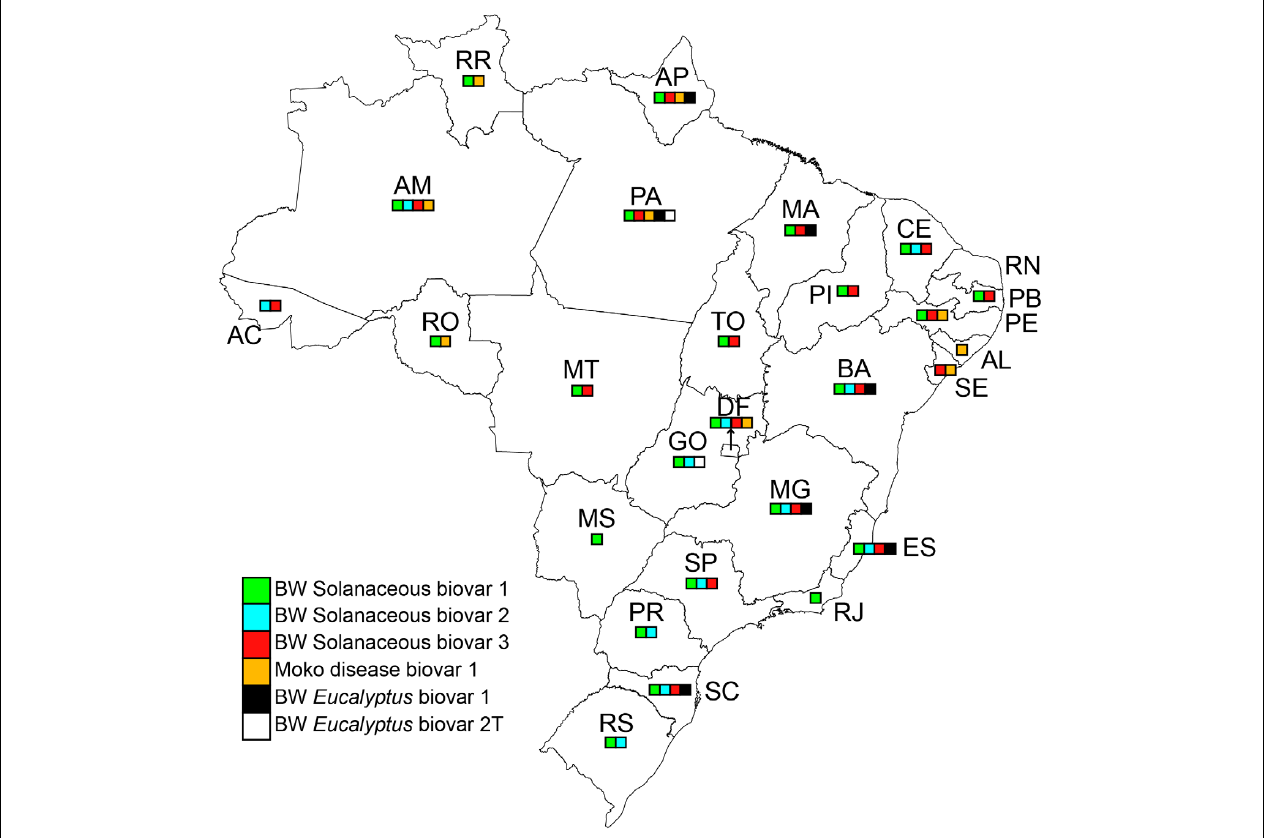
FIGURE 1 | Brazilian map with state division representing the presence of Ralstonia species and diversity considering the reported data at the time and the list of isolates from the Embrapa Hortaliças collection, Albuquerque et al. (2014), Morais et al. (2015), and Santiago et al.